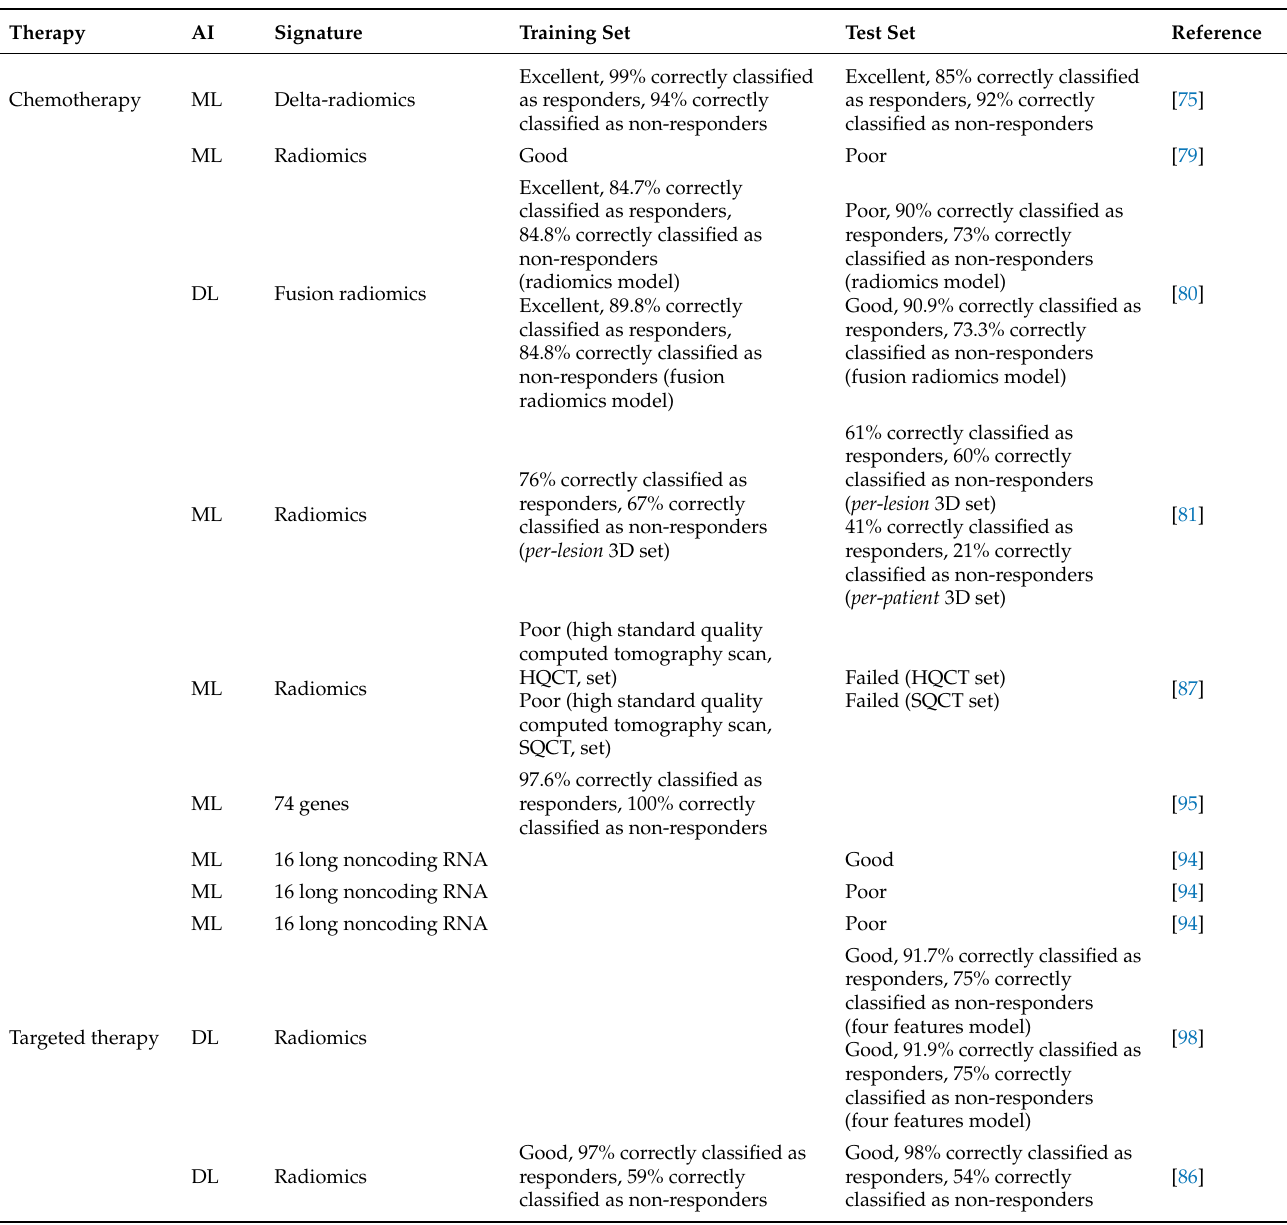
Table 6. Performances of the artificial intelligence